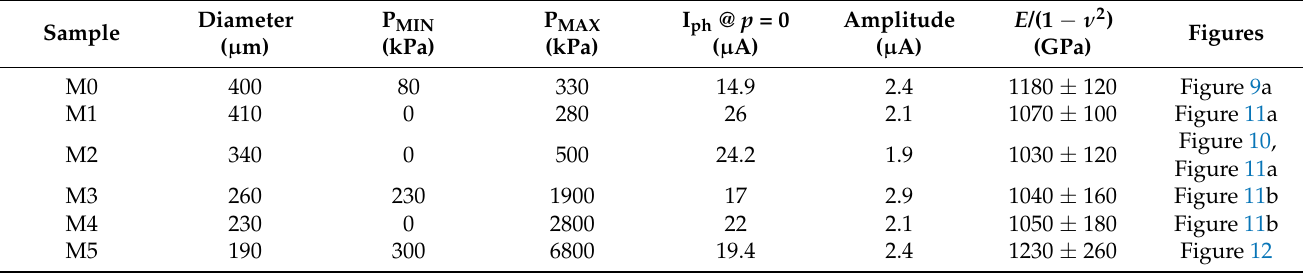
Table 1. Main characteristics of the selected